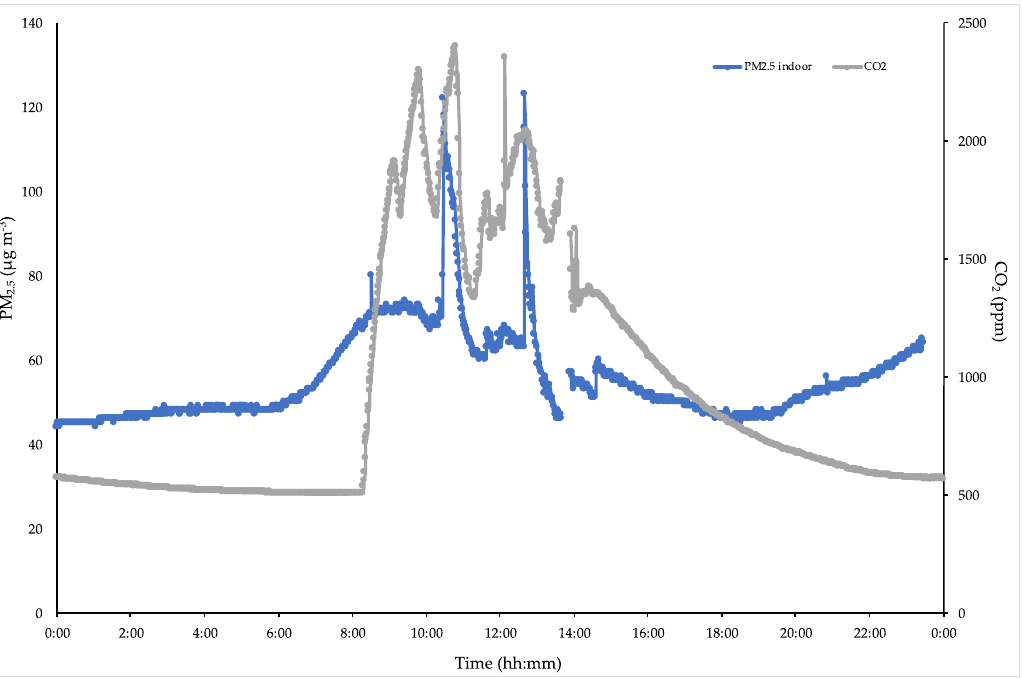
Figure 3. Typical indoor PM 2.5 and CO 2 behaviors in classes where only school activities are daily performed.